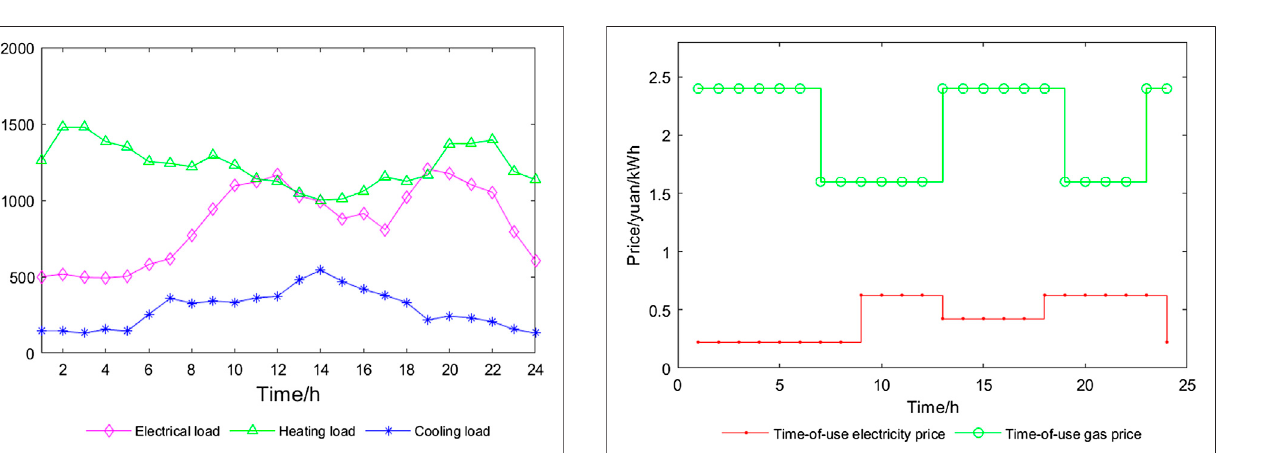
FIGURE 5 | Hourly price changes in electricity and gas prices.